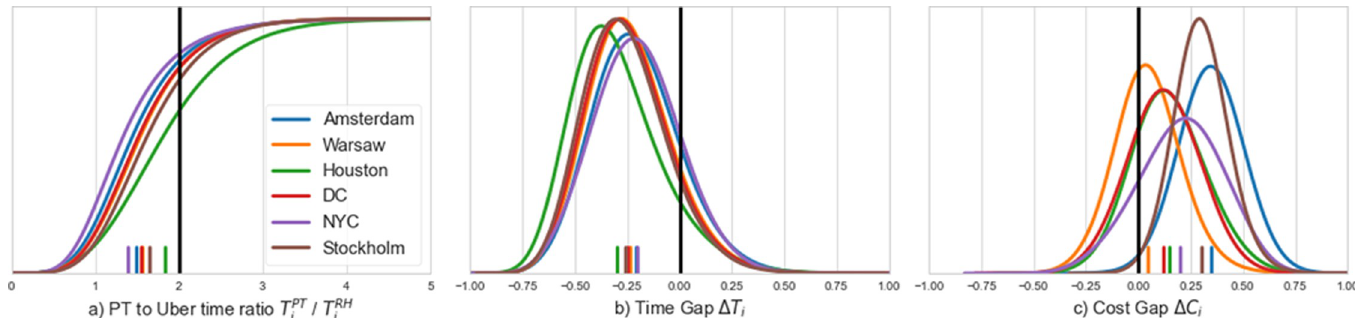
Fig 2. The cumulative density function of the ratio between the nominal journey time of public transport and ride-hailing (a), and the histograms of the Modal Accessibility Gap (positive for competitive PT and negative otherwise) between public transport and ride-hailing in terms of (b) nominal journey time and (c) generalized travel